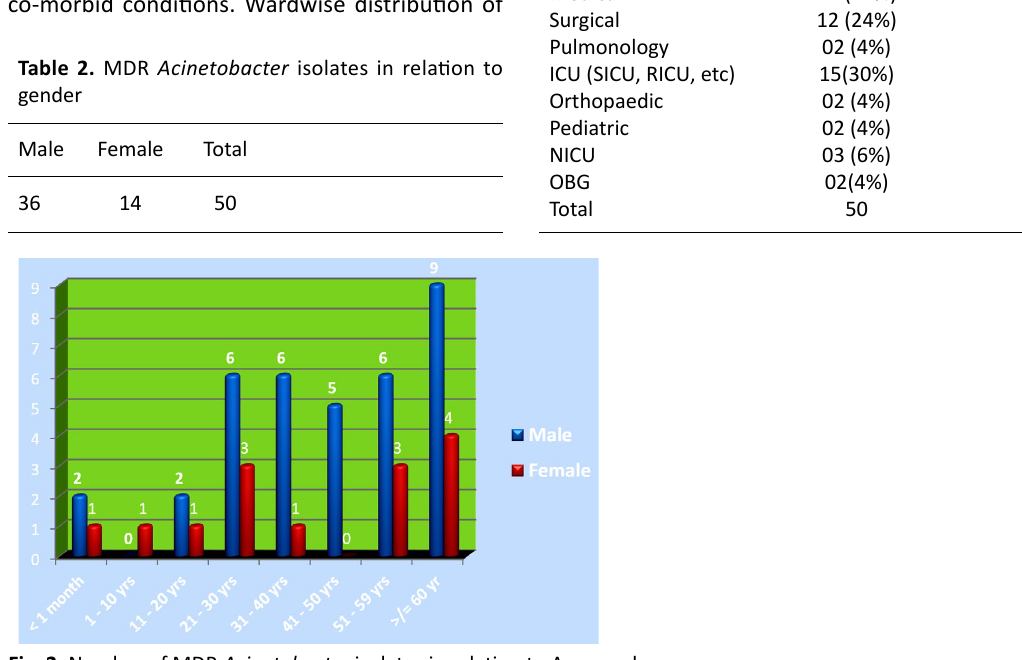
Fig. 2. Number of MDR Acinetobacter isolates in relation to Age-gender